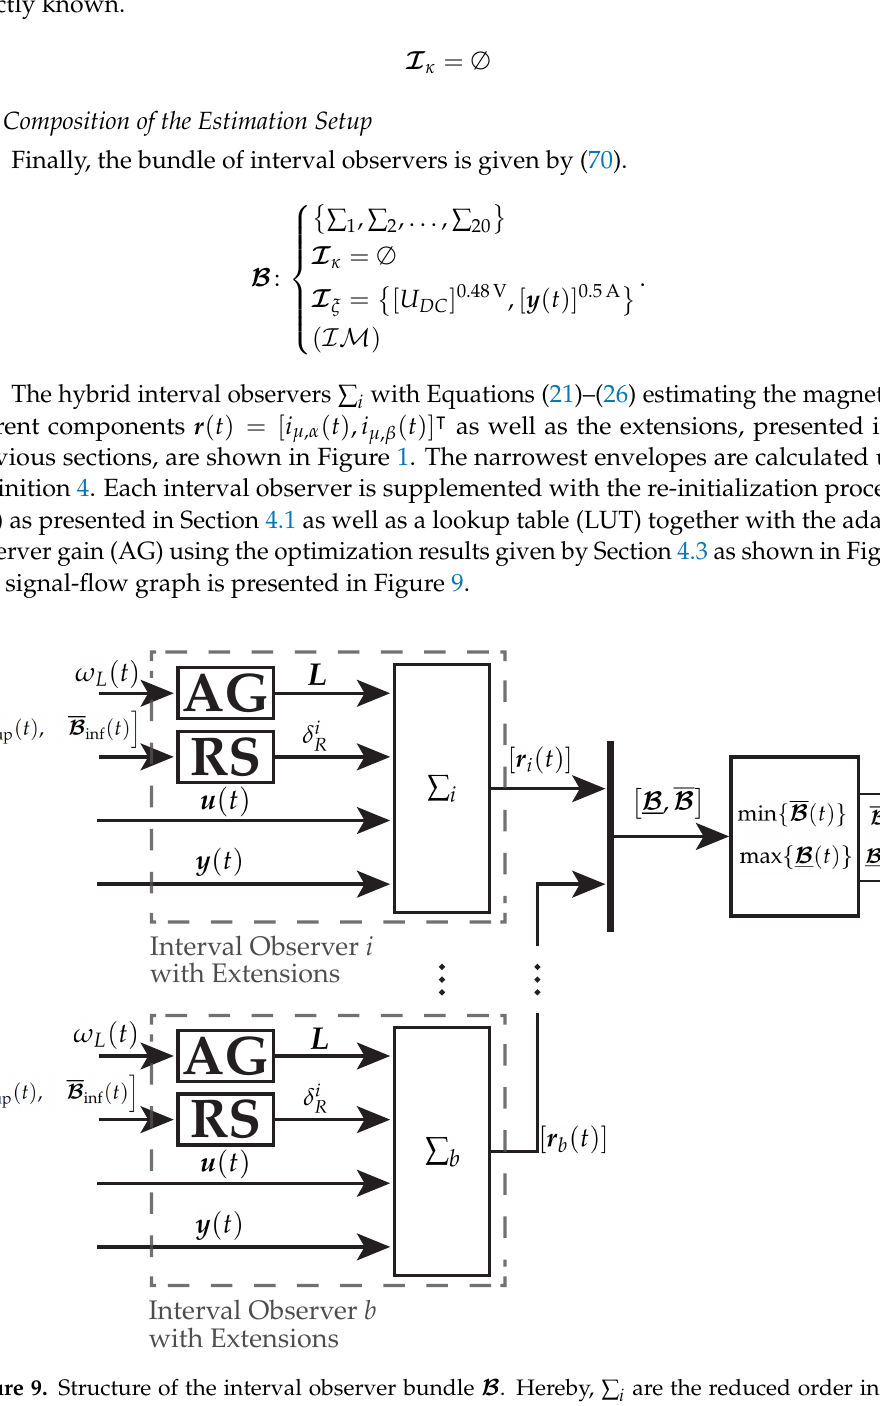
Figure 9. Structure of the interval observer bundle B . Hereby, ∑ i are the reduced order interval observers considered within the bundle and [ r i ( t )] are the estimated interval values. The best envelopes l ( B ) ( t ) are calculated with B inf ( t ) and B sup ( t ) , see Definition 4. Adaptive observer parameters are obtained based on ω L ( t ) with the adaptive observer gain (AG) and re-initialization conditions are monitored within the re-initialization structure (RS) providing the re-initialization signal δ i R